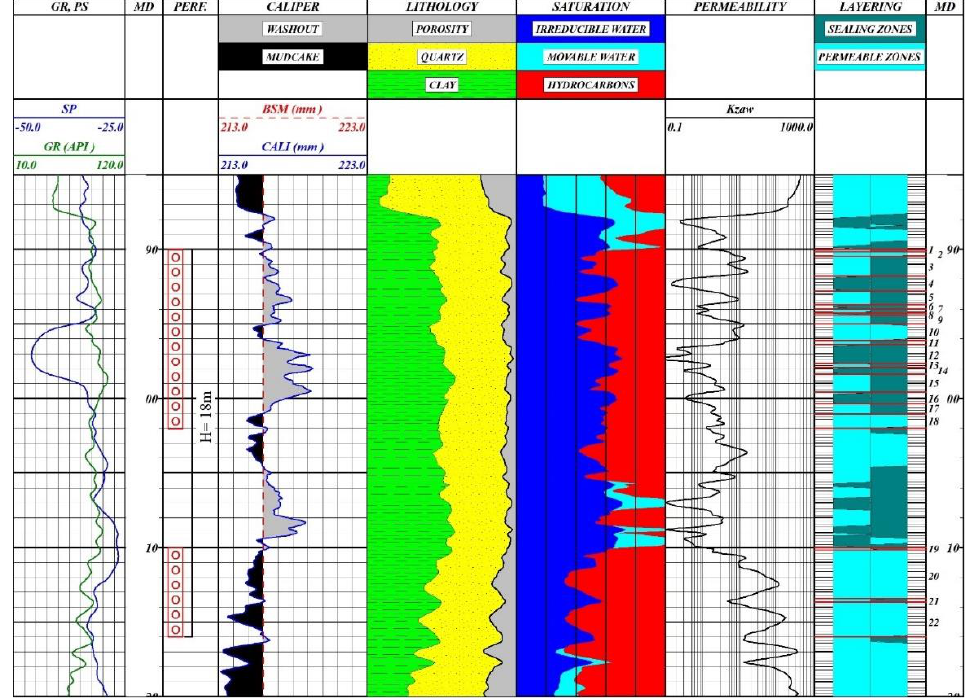
Figure 8. The results of the interpretation of the permeability change profile within the analysed perforation intervals in the J-8K well. perforation intervals in the J-8K